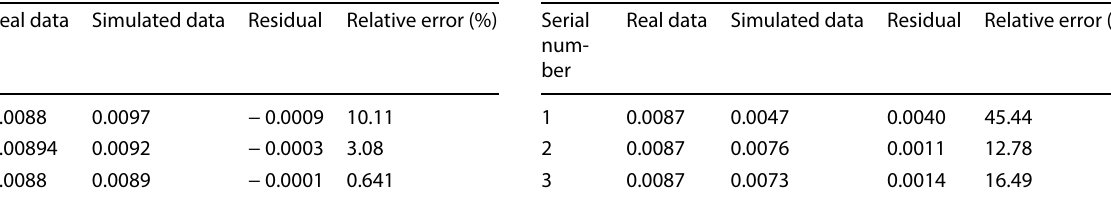
Table 7 24-h stable production data after N Sequence